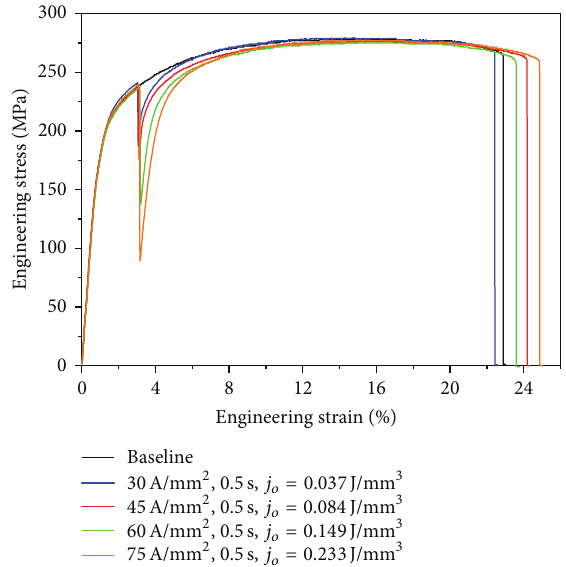
Figure 4: Engineering stress-strain curves with different electric pulse parameters.